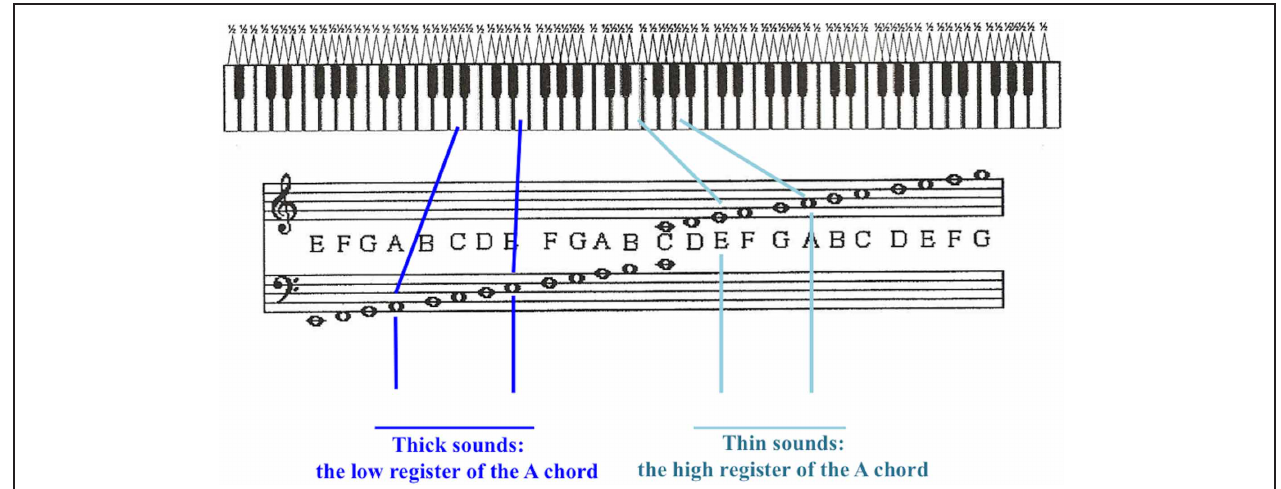
FIGURE 1 | Musical notation and octaves on piano of notes played on the guitar in MSTT. Blue lines indicate notes in “thick sound;” teal lines indicate “thin sound.”